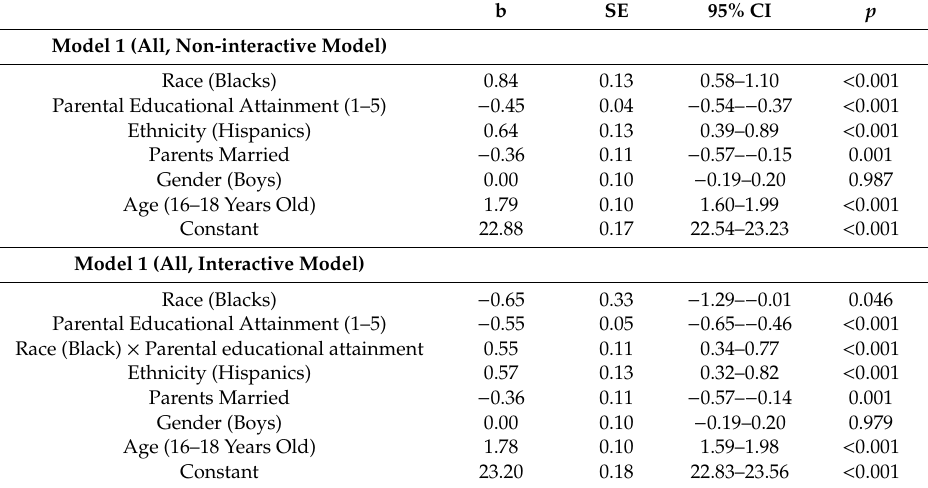
Table 2. Summary of linear regressions on body mass index (BMI) in the pooled sample. b SE 95% CI p Model 1 (All, Non-interactive Model)